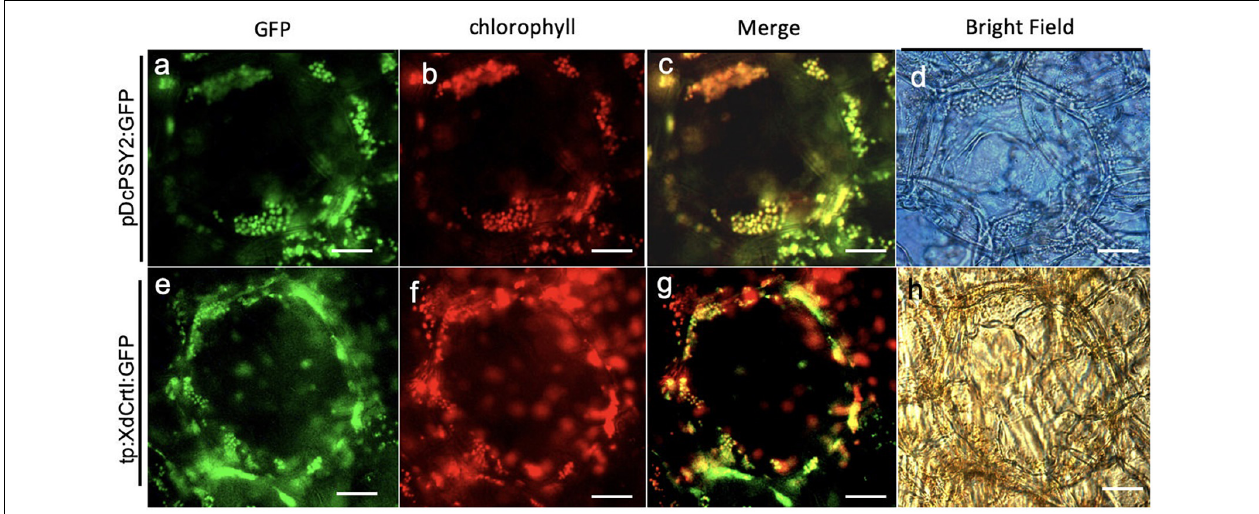
FIGURE 3 | Subcellular localization of DcPSY2 and XdCRTI. Transient transformation of tomato fruits agroinfiltrated with DcPSY2:GFP or XdCrtI:GFP fused to a transit peptide (tp). The expression of both constructs was driven by the pPG promoter. Fluorescence was observed 4 days after transient transformation. (a) GFP fluorescence of DcPSY2:GFP. (b) Chlorophyll autofluorescence of (a) . (c) Merge of panels (a,b) , showing colocalization of chlorophyll and the GFP signal. (d) Bright field of (a–c) . (e) GFP fluorescence of tp:XdCRTI:GFP. (f) Chlorophyll autofluorescence of (e) . (g) Merge of panels (e,f) , showing colocalization of chlorophyll and GFP signal. (h) Bright field of (e–g) . The TRITC filter U-N31001 was used for visualizing GFP fluorescence, with an excitation wavelength between 465 and 495 nm. Emission was collected between 513 and 556 nm. Chlorophyll autofluorescence was assessed by using a U-MNG2 filter, with an excitation wavelength between 530 and 550 nm and emission collected at 590 nm. Scale bar = 50 µ